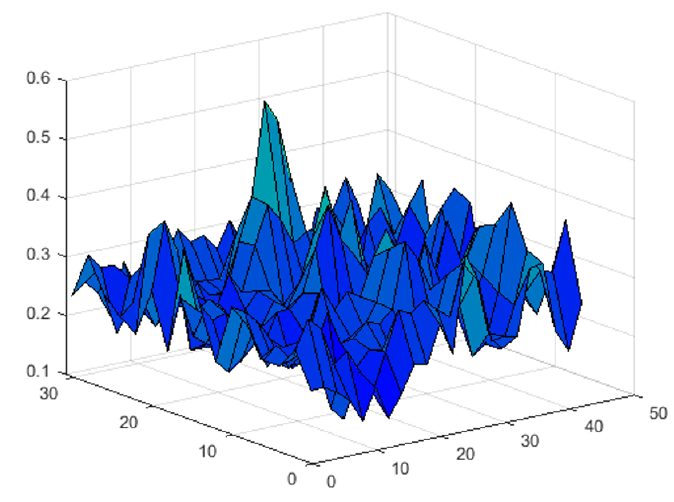
Figure 11. The 2D map of the R max